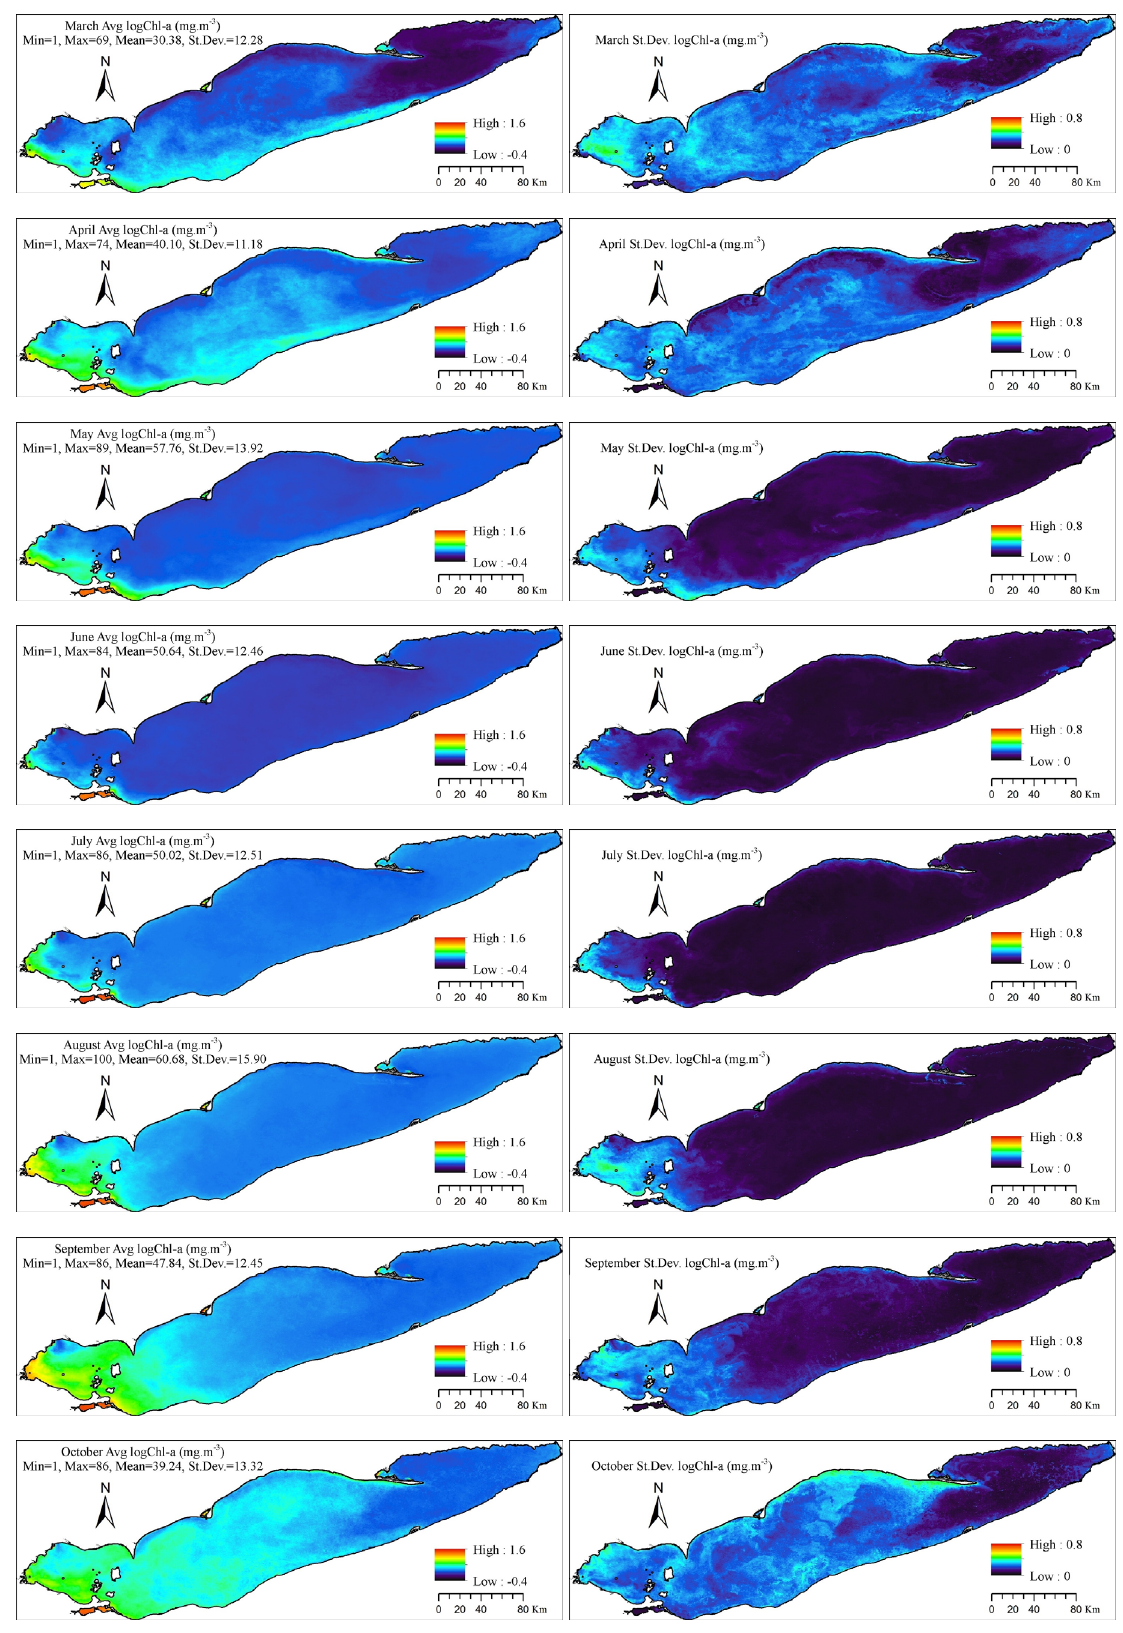
Figure 7. Chl-a average (Avg, ( a )) and standard deviation (St.Dev., ( b )) in log 10 scale from March to October for the study period (2005–2011). The statistics shown on the left figures are related to the number of available pixels for each